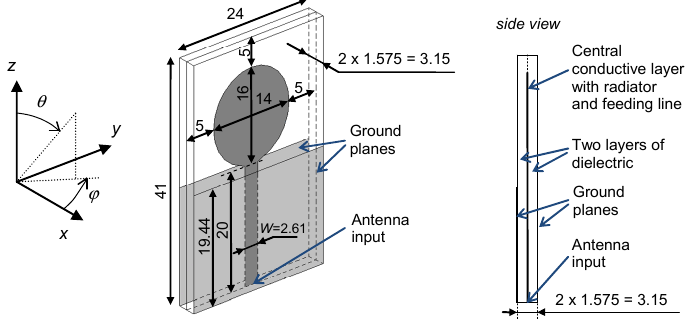
Figure 1. Geometry of proposed single prototype UWB antenna (dimensions in mm).